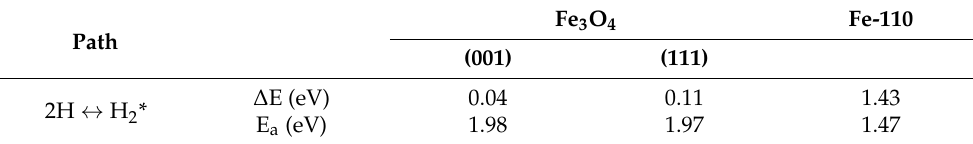
Table 2. The energy barrier and reaction heat (eV) of H 2 formation on Fe (110) and Fe 3 O 4 (111)-Fe tet1 and